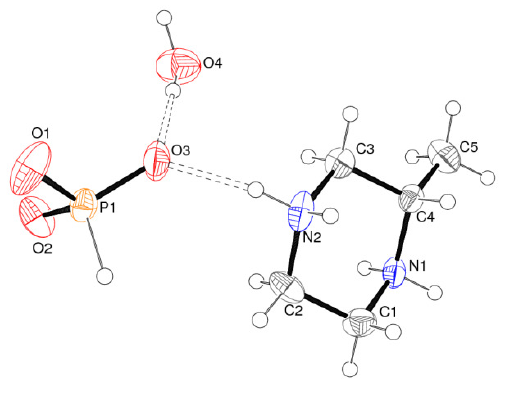
Figure 1. The molecular structure of 1 showing 50% displacement ellipsoids.